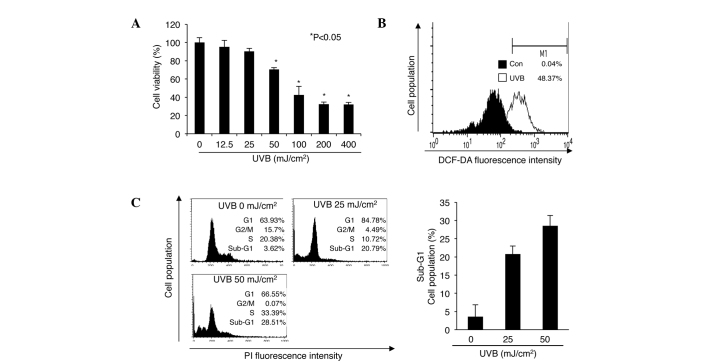
Effect of UVB irradiation on cell viability, ROS production and the cell cycle in nHDPs. (A) Effect of UVB radiation on nHDP viability. Cell viability was measured by MTT assay. Results are presented as the mean ± standard error of the percentage of control OD of triplicate samples. *P<0.05 vs. 0 mJ/cm2 UVB irradiation. (B) Effect of UVB on the levels of ROS in nHDPs. Different cell populations are represented by different colors (black, 0 mJ/cm2 UVB; white, 50 mJ/cm2 UVB). (C) Effect of UVB on the cell cycle in nHDPs. The distributions of cells of different populations in the different stages of the cell cycle were analyzed by flow cytometry using PI-stained nHDPs. The frequency of cells in the sub-G1 phase is presented as the mean ± standard error of the percentage of the gated cell population of triplicate samples. UVB, ultraviolet B; DCF-DA, 2′,7′-dichloroflorescein diacetate; PI, propidium iodide; ROS, reactive oxygen species; nHDP, normal human dermal papilla cell; OD, optical density.